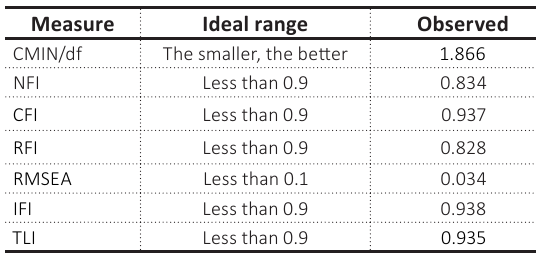
Table 6. Model-fit indices